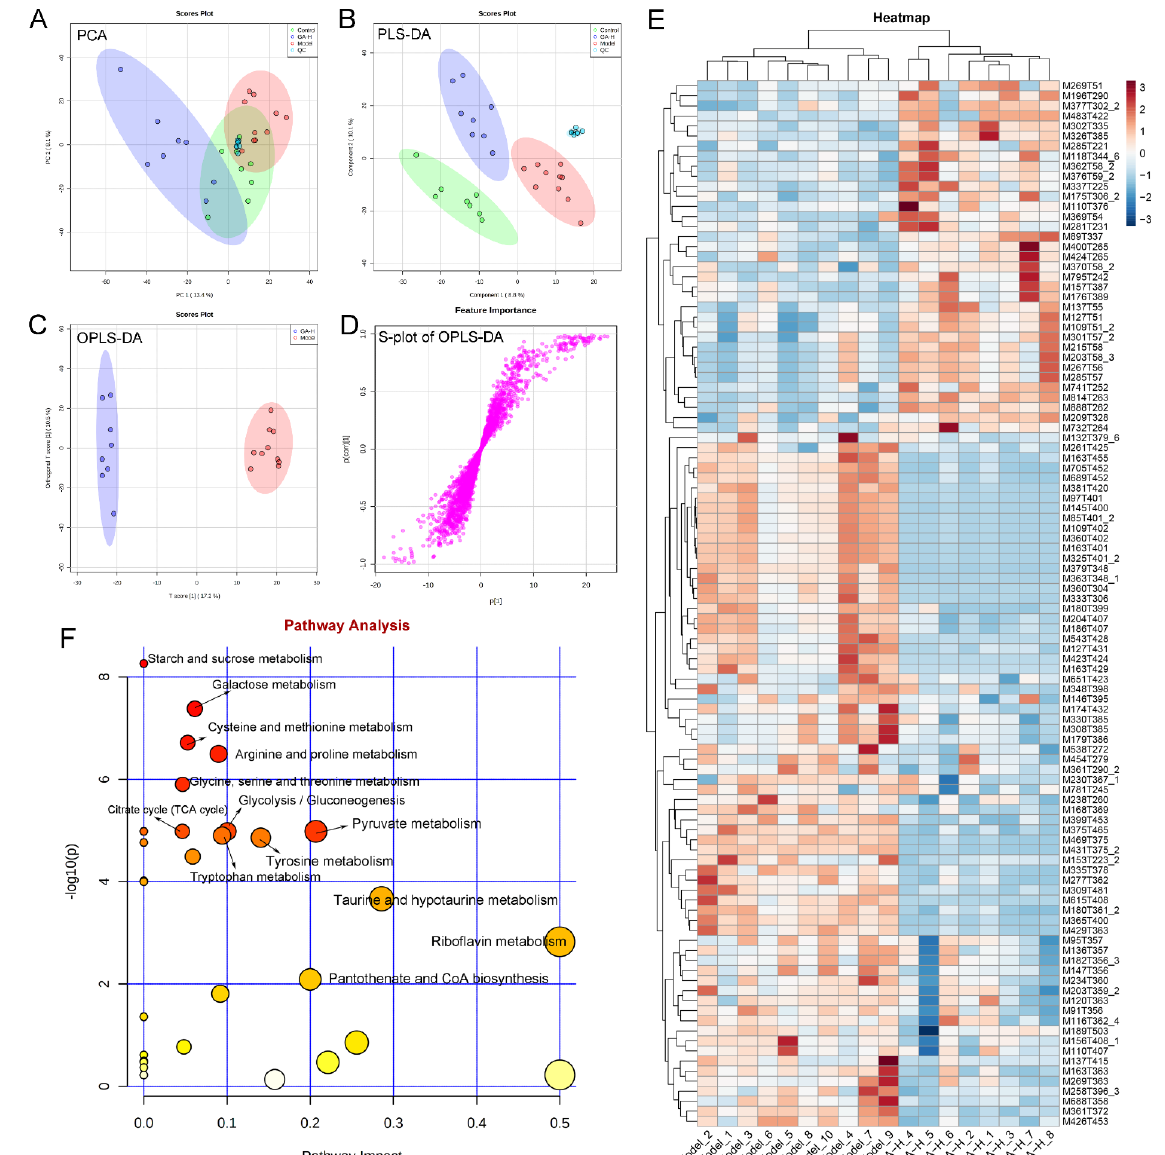
Figure 7. Effects of high-dose GA administration on liver metabolome in mice with excessive alcohol intake revealed by UPLC-QTOF/MS-based metabonomics in ESI+ mode. ( A ) PCA score plot; ( B ) PLS-DA score plot; ( C ) OPLS-DA score plot; ( D ) S-loading plot based on OPLS-DA analysis; ( E ) heatmap of liver metabolites with significant differences between groups (VIP value > 1.0, p < 0.05) between the model and GA-H groups; ( F ) metabolic pathway prediction based on the KEGG database.